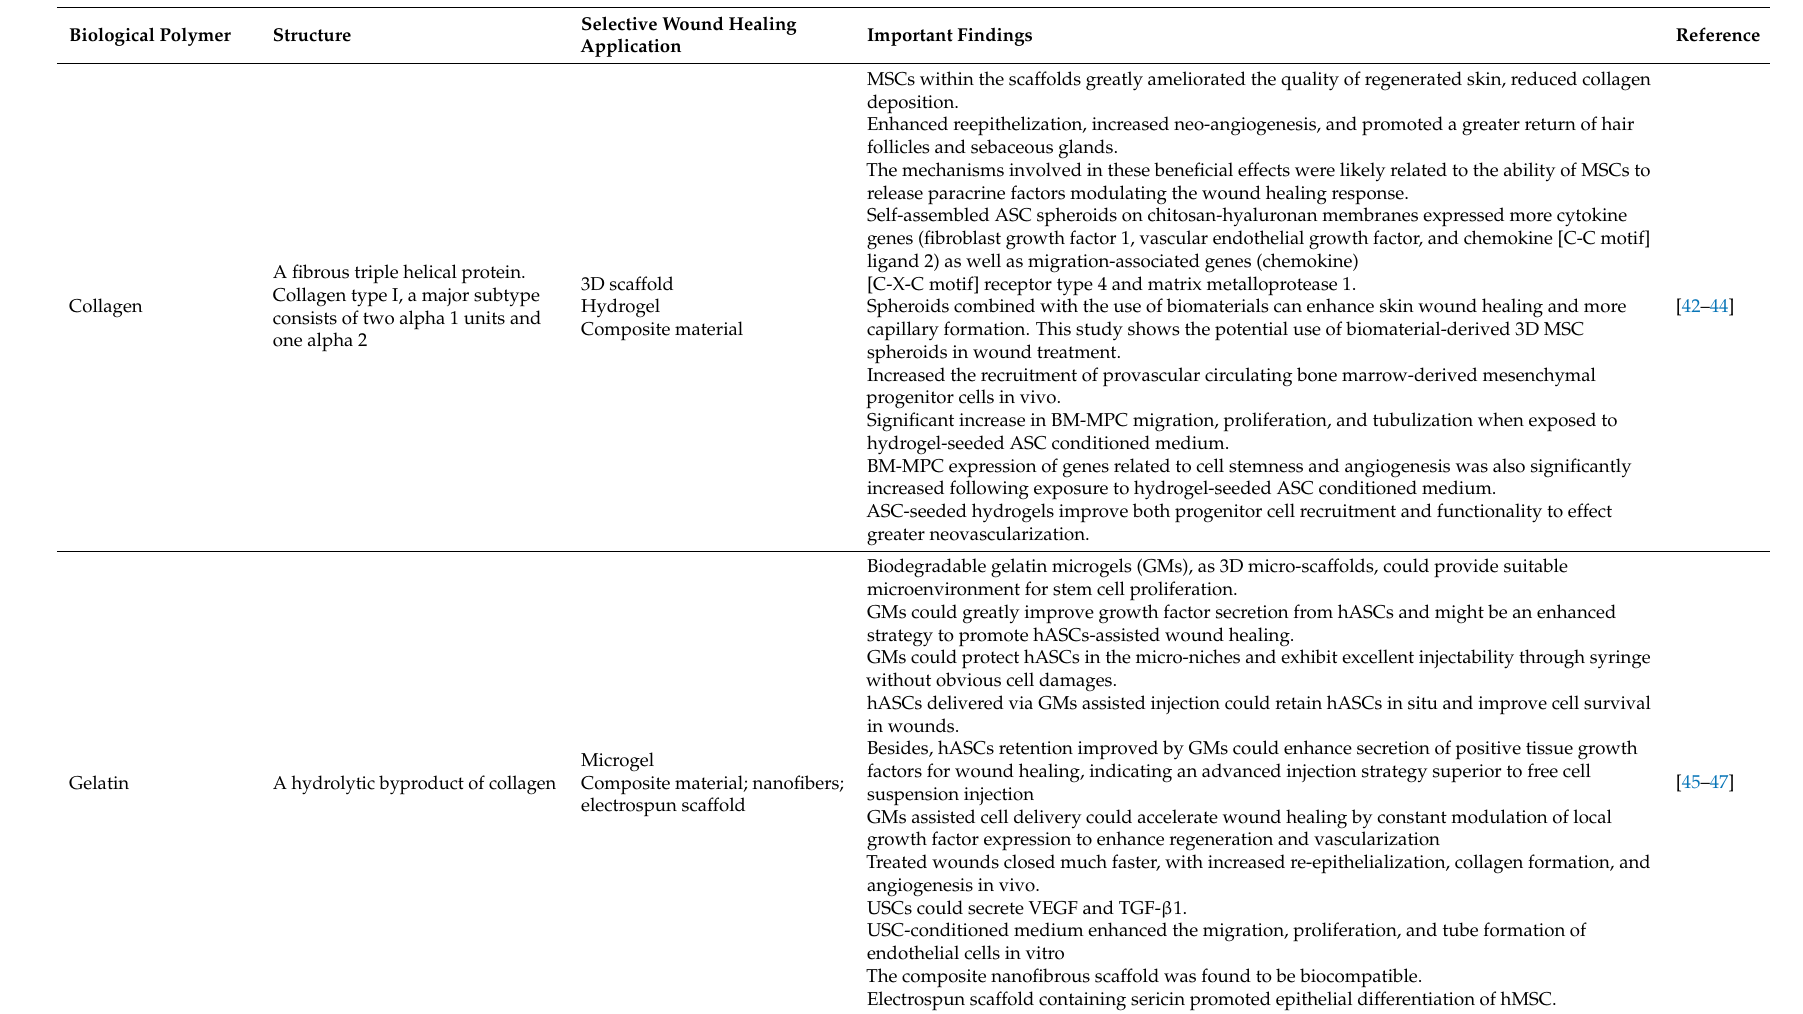
Table 1. Biological polymers for wound healing